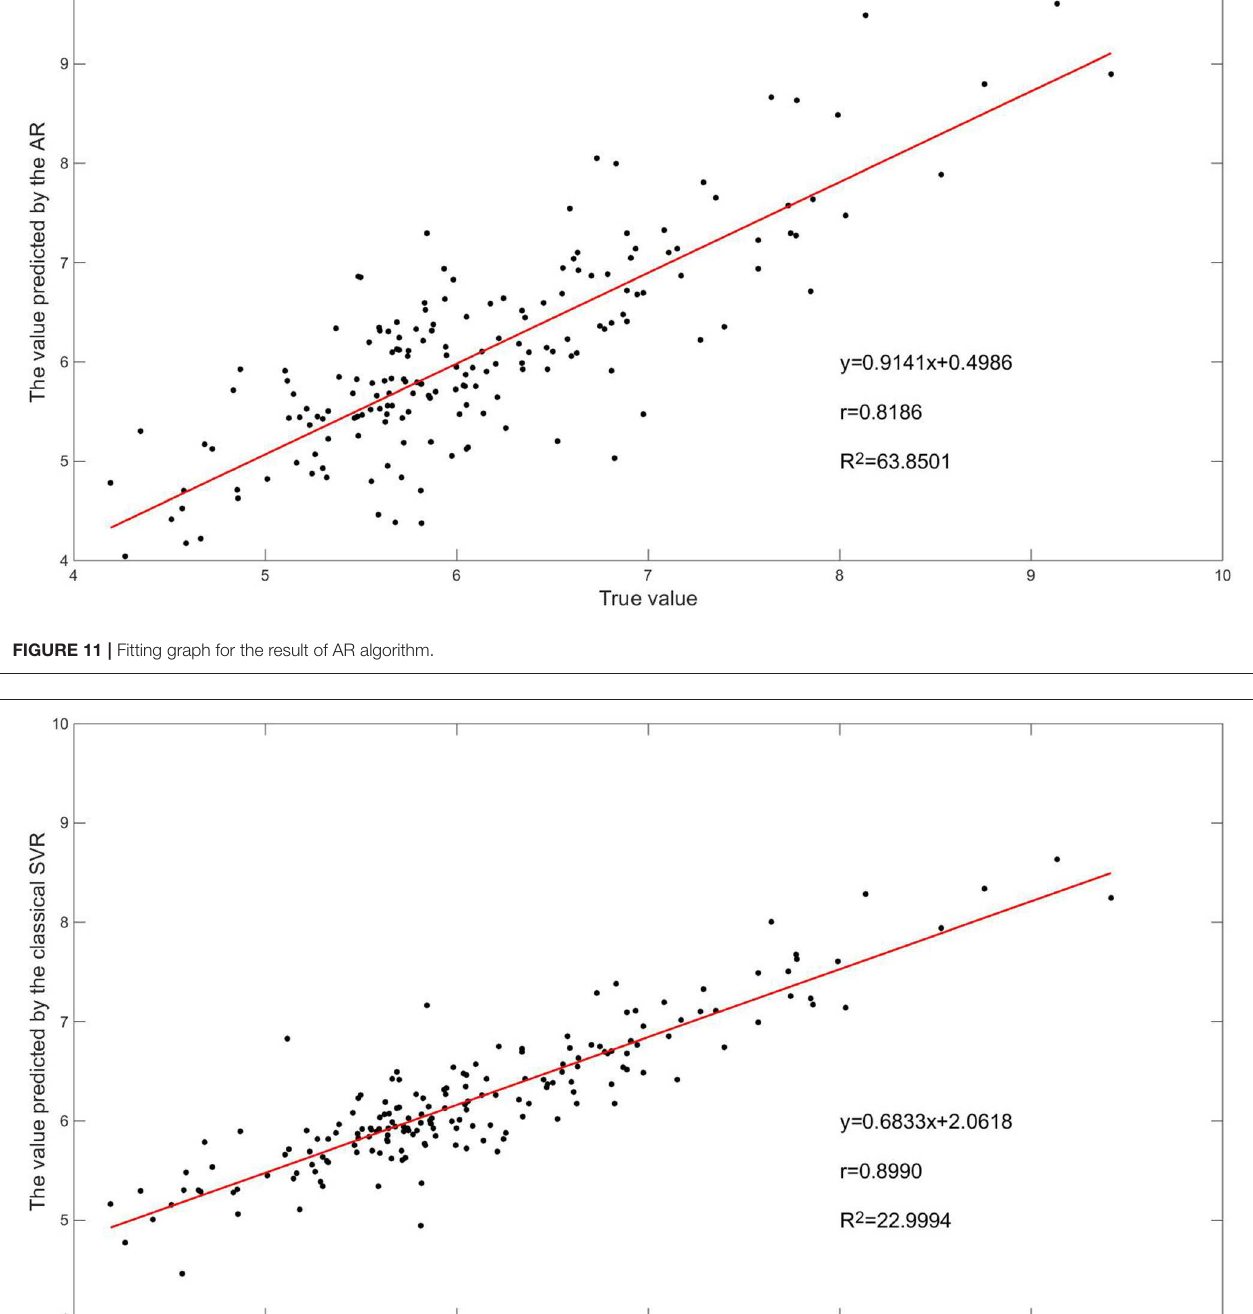
is 37% lower than that of the traditional AR algorithm and 15% lower than that of the classical SVR algorithm. It has